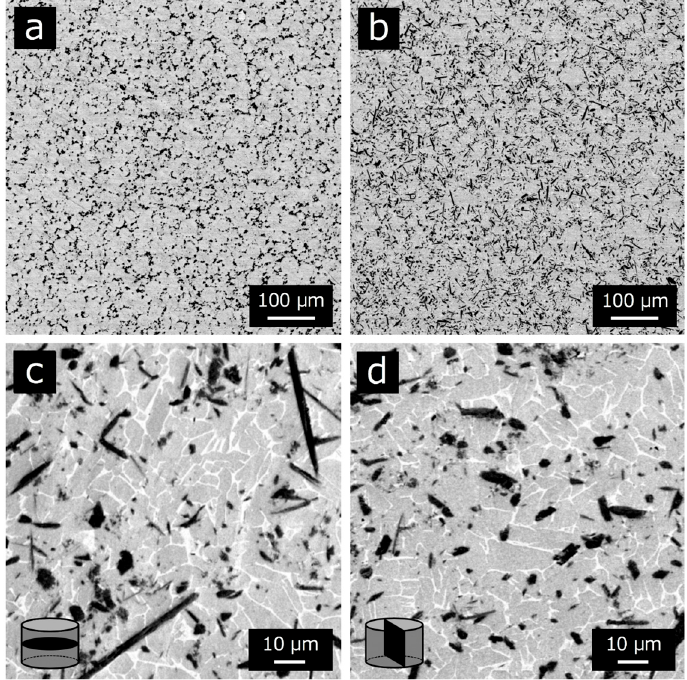
Figure 3. SEM images of SPS compacts consolidated for 30 min (~12.5 vol.% TiB in the final composite) at ( a ) 800 °C, ( b ) 1100 °C, ( c ) 1100 °C in direction perpendicular to the load (high magnification) and ( d ) 1100 °C in direction parallel to the load (high magnification).